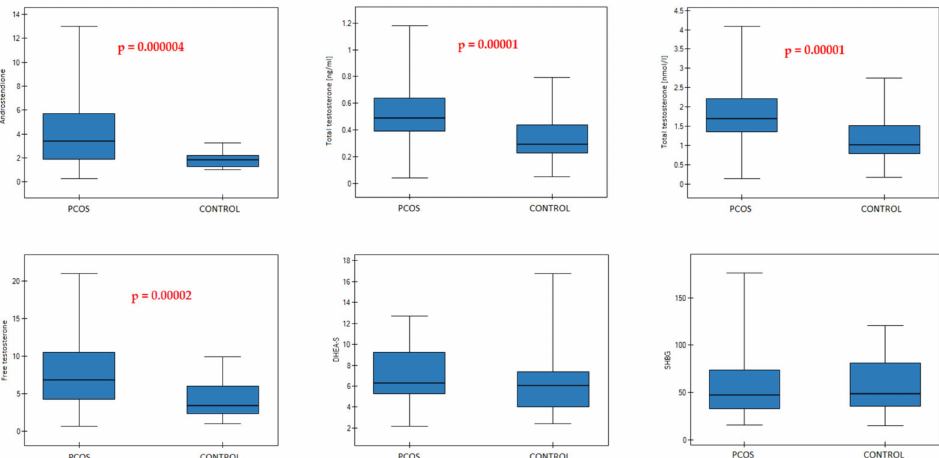
Figure 1. Median (25–75%) values of sex hormones in PCOS and CONTROL groups. p values are included when hormone concentrations significantly differed between the two